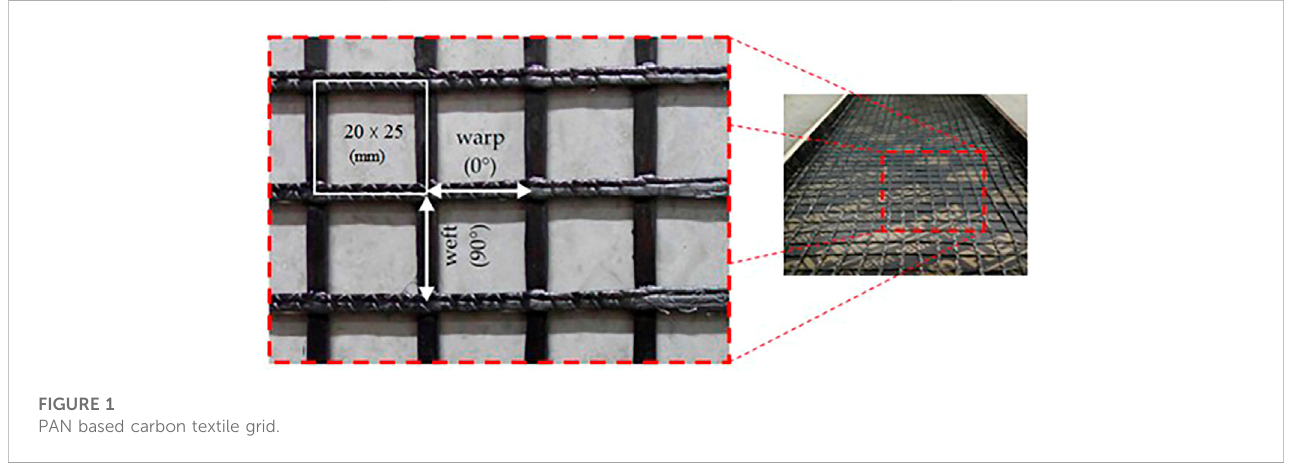
FIGURE 1 PAN based carbon textile grid.